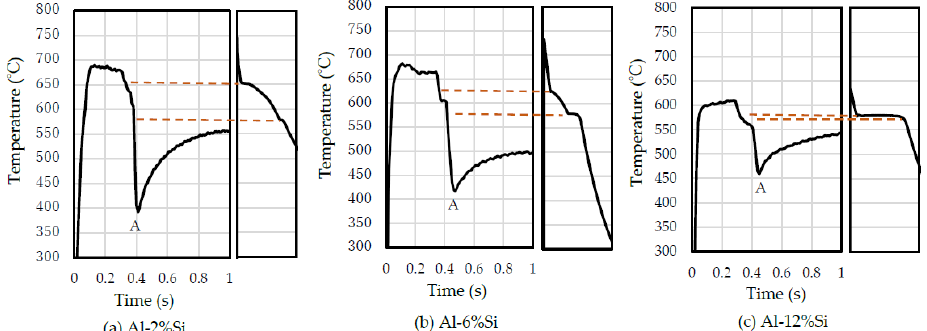
Figure 3. Cooling curves (time–temperature diagrams) for aluminum alloys cast using a VHSTRC and an insulated mold. Left and right sides of each panel are the cooling curves for the VHSTRC and the insulated mold, respectively. The roll speed was 30 m/min and roll load was 20 kN for casting using a VHSTRC. Dashed lines show the liquidus and solidus temperatures attained using the insulated mold.